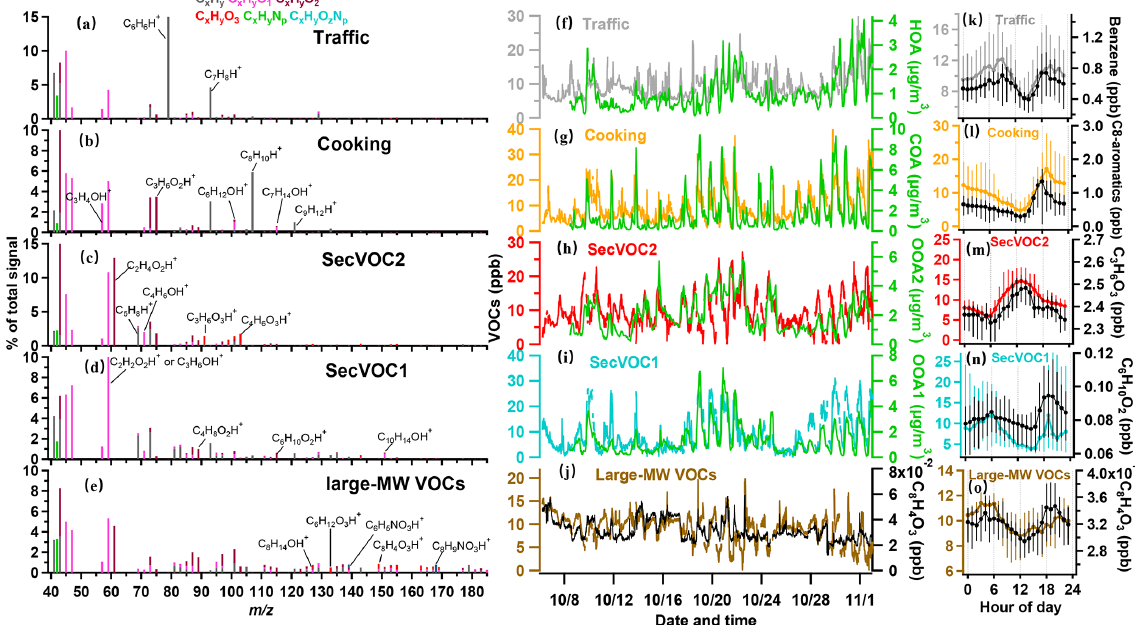
Figure 3. Source-attributed VOCs by the PMF analysis measured by the PTR-ToF-MS. (a–e) Mass spectra of the five factors (traffic VOCs, cooking VOCs, and secondary VOCs of SecVOC2 and SecVOC1) and large molecular weight (MW) VOCs (large-MW VOCs), with major fingerprint peaks labelled in the mass spectra. (f–j) Temporal variations in the five VOCs factors and their respective correlated OA species. (k–o) Diurnal profiles of the VOC factors and their respective signature species. The lines and whiskers denote the median, the 25th, and the 75th percentiles at each hour,